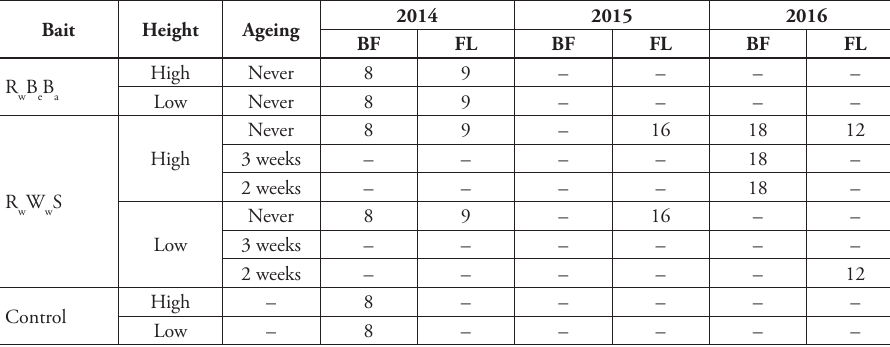
Table 2. Overview of the trap sample and number of traps set in the two study areas, Bosco della Fontana (BF) and Foresta della Lama (FL), during the three years of monitoring. Baits: R Banana); R W S (Red Wine, White Wine, Sugar); Control (empty traps used as control). Height at which w w traps were set: High (above 10 m), Low (1.5–2 m). Variation in ageing of the mixture: Never (mixture never changed during the season); 3 weeks (mixture changed once during the season: after three weeks); 2 weeks (mixture changed twice during the season: every 2